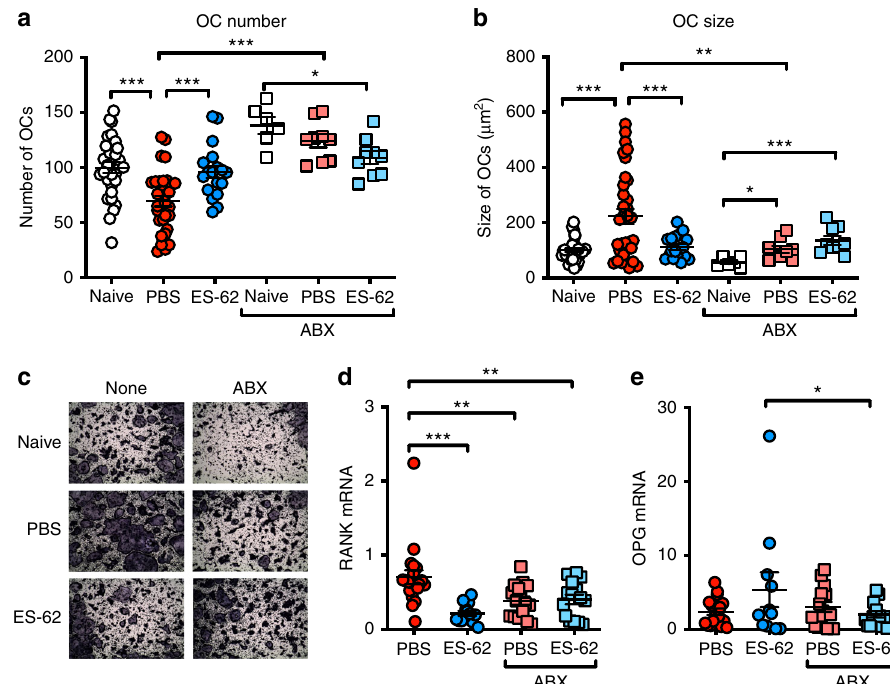
Fig. 3 ES-62 requires the gut microbiome to protect the bone remodelling axis. a – c Osteoclasts (OCs) were differentiated from bone marrow obtained at cull and cultured for 5 days before differentiation, in terms of numbers ( a ) and size ( b ) of OCs, was measured using ImageJ analysis software and data were normalised as a percentage of Naive controls with representative images ( c ) provided (Naive; n = 11, PBS; n = 11, ES-62; n = 6, Naive + ABX; n = 2, PBS + ABX; n = 3, ES-62 + ABX; n = 3). Whole bone marrow was used to quantify RANK ( d ; PBS; n = 20, ES-62; n = 13, PBS + ABX; n = 15, ES-62 + ABX; n = 15) and OPG ( e ; PBS; n = 17, ES-62; n = 11, PBS + ABX; n = 16, ES-62 + ABX; n = 14) mRNA levels using qRT-PCR, and fold change was calculated following normalisation to Naive controls. Statistics: all data are presented as mean ± SEM. In a and b , each symbol represents experimental replicates and in d and e each symbol represents individual mice and data are pooled from three independent experiments. Statistical signi fi cance was determined using one-way ANOVA with LSD Fishers multiple comparisons and signi fi cance indicated by asterisks, * p < 0.05, ** p < 0.01 and *** p <